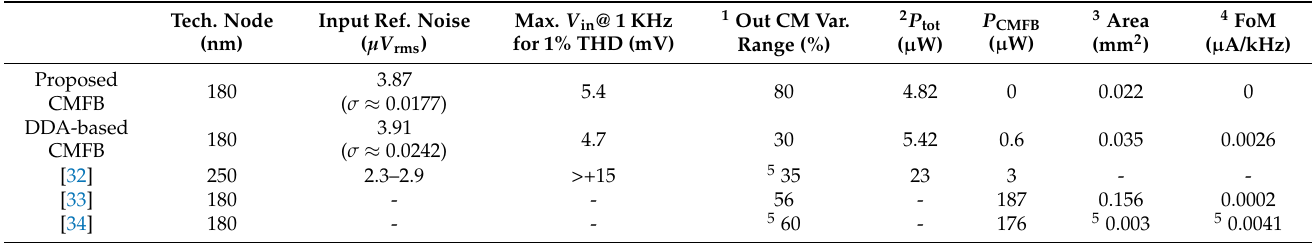
Table 1. Performance comparison of the neural recording amplifiers with the conventional DDA-based and proposed CMFBs, and other recent standalone CMFBs. Tech. Node